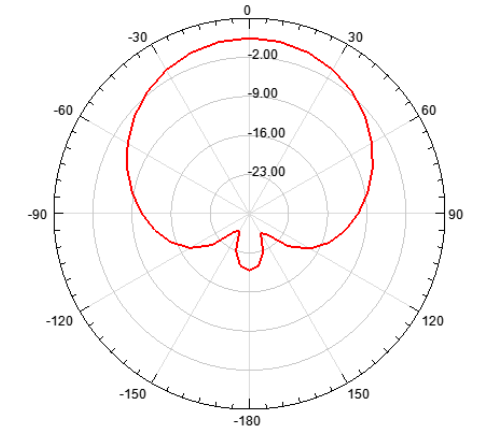
Fig.1.9 2D Radiation Pattern of the Antenna 2